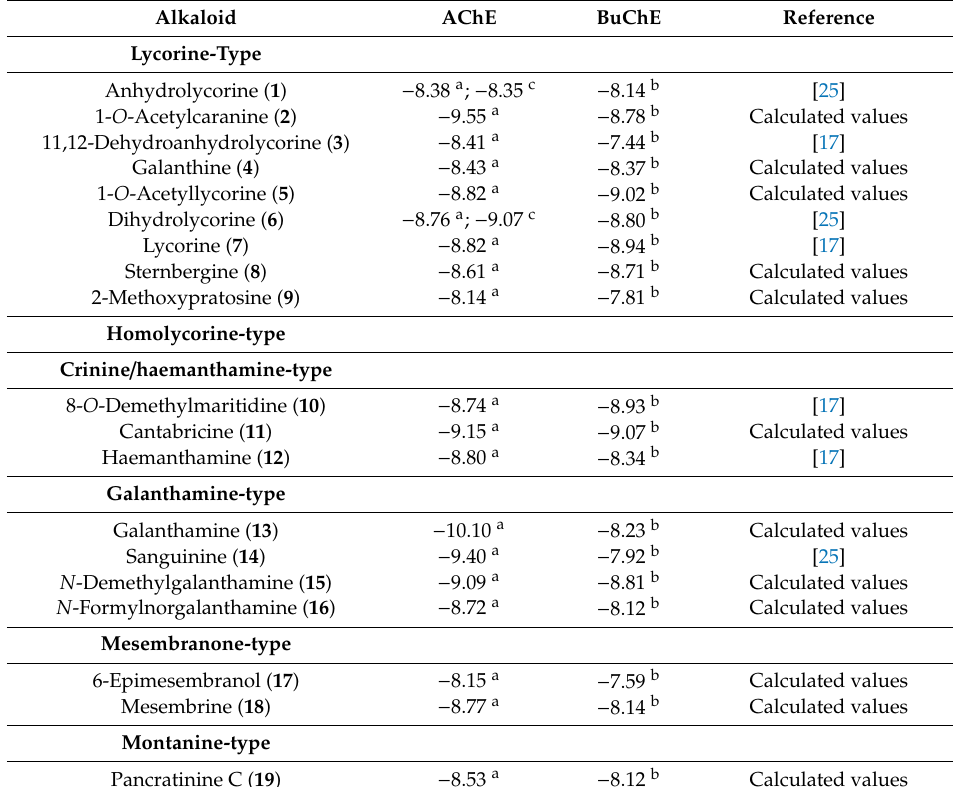
Figure 4. AChE and BuChE inhibitory activities of five different Phaedranassa Herb. species from Ecuador. Values are expressed as IC 50 (µg·mL − 1 ). A : P. cinerea ; B : P. cuencana ; C : P. dubia ; D : P. glauciflora ; E : P. tunguraguae ; GAL : Galanthamine control. **** p < 0.0001, *** p < 0.001, * p < 0.5, and ns (not significant). Table 2. Estimated binding free energy in molecular docking of alkaloids identified in extracts of Phaedranassa Herb. species toward cholinesterases (AChE and BuChE). Values expressed in kcal · mol − 1 . Alkaloid AChE BuChE